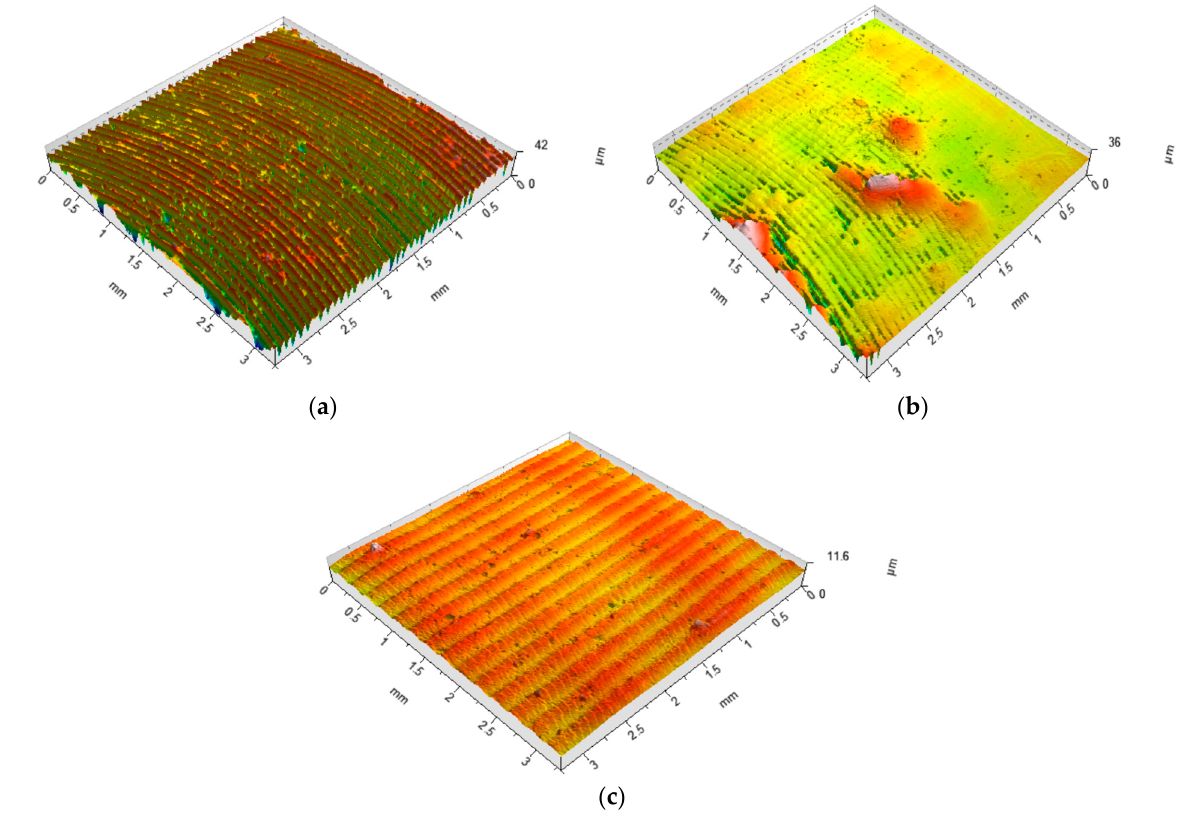
Figure 6. Isometric views ( a ) of the base surface and the SDB surfaces: ( b ) 𝑃 (cid:3404) 40 N , 𝑓 (cid:3404) 1000 mm/min (experimental run no. 2), ( c ) 𝑃 (cid:3404) 60 N , 𝑓 (cid:3404) 1000 mm/min (experimental run no. 8). f = 1000 mm/min (experimental run no. 2), ( c ) P = 60 N, f = 1000 mm/min (experimental run no.